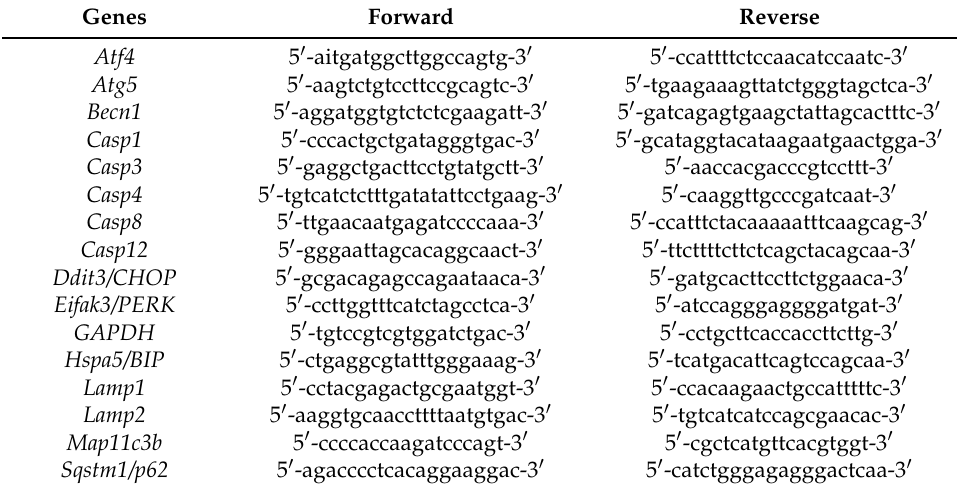
Table 1. Sequences of primers for